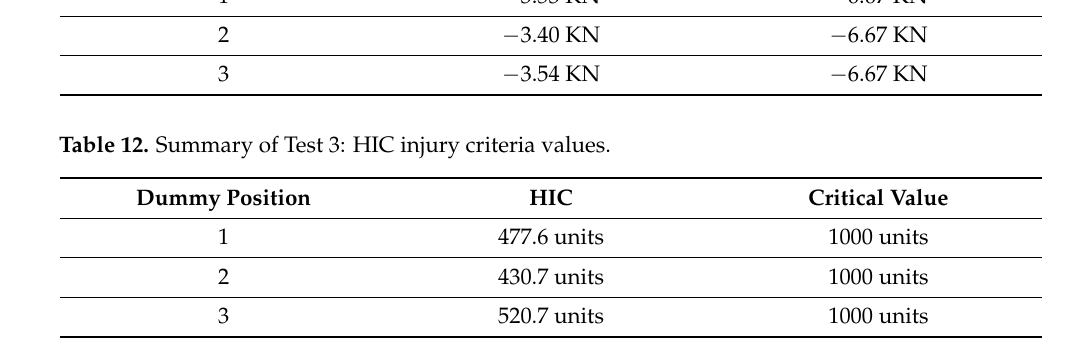
Table 13. Summary of Test 3: Femurs’ maximum compressive force values.